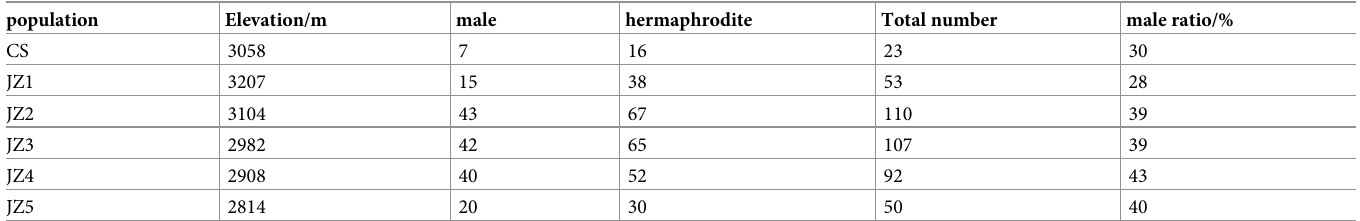
Table 1. Male ratio of O . delavayi from 6 populations in Yunnan.